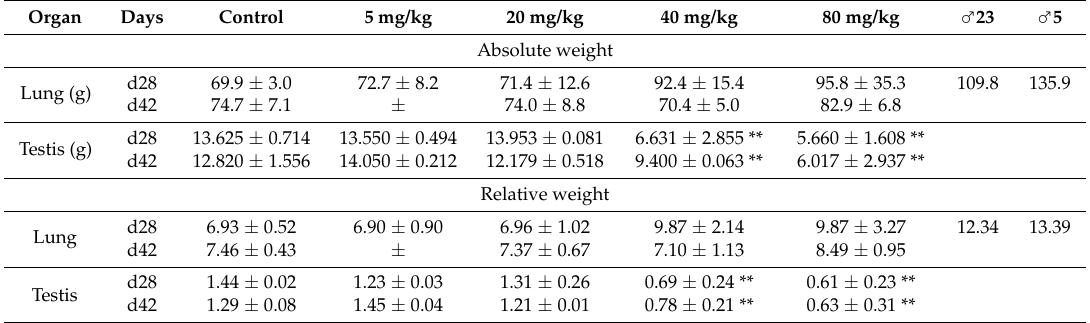
Table 4. Selected absolute and relative organ weights induced by HZ1006 in dogs following repeated dose administration after 28 days of continuous treatment and 14 days of recovery (only significant results are